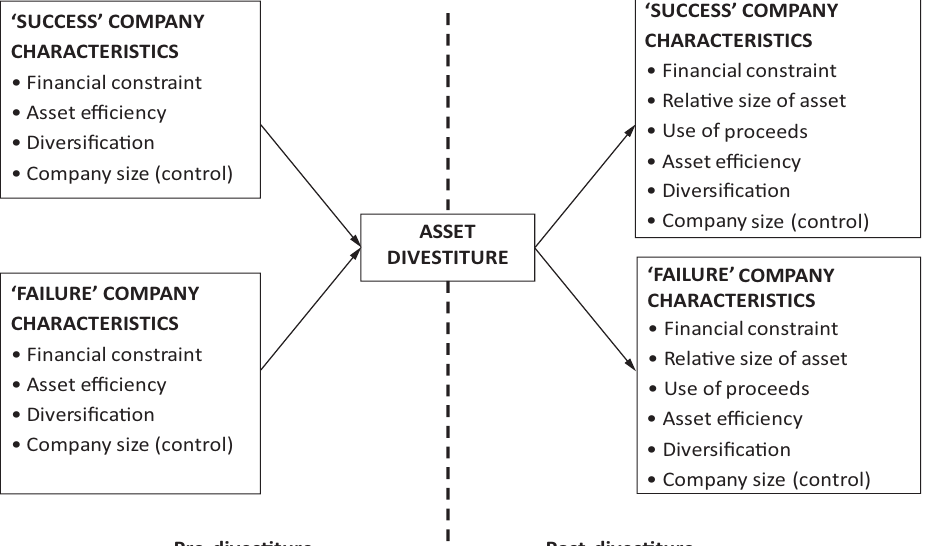
Figure 1. Research